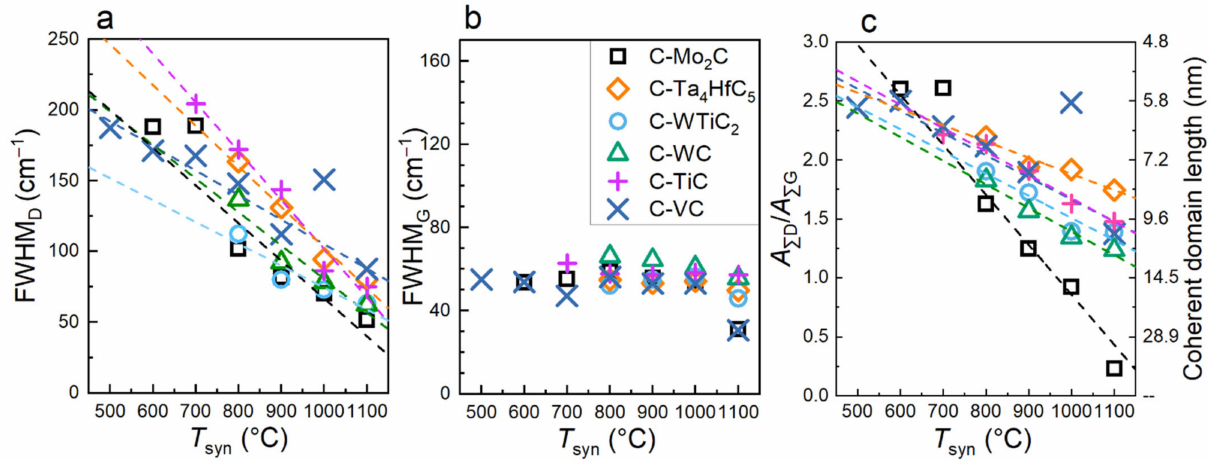
Figure 4. The full-width half maximum of the ( a ) D-band (FWHM D ), ( b ) the G-band (FWHM G ) and ( c ) the ratio A ∑ D / A ∑ G (Equation (5)), versus the synthesis temperature of the CDC. The axis on the right shows the L a = 490/ E laser4 (S Σ D /S Σ G ) − 1 [27]. Parameters are obtained from spectra (laser wavelength 514 nm) of CDCs with different precursor carbides (noted in Figure) using the L + L + G + L + L deconvolution method. Lines are guides for the